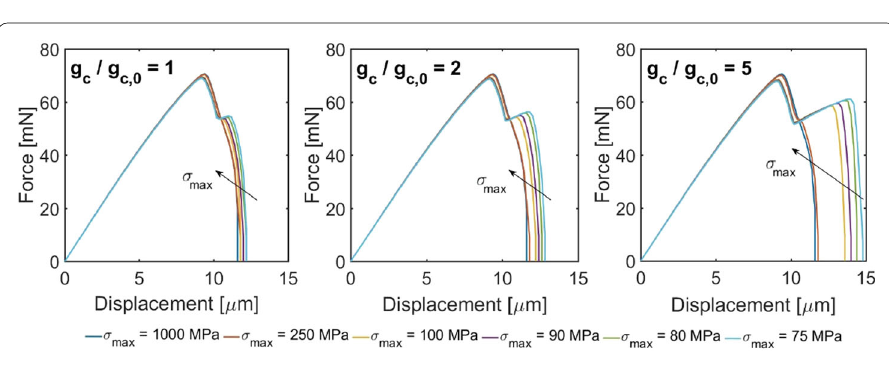
Fig. 13 Force displacement curve for different σ max and different ratio g c / g c,0 (from [47]) critical opening displacements for the undamaged and fully damages states, g c / g c, 0 ,